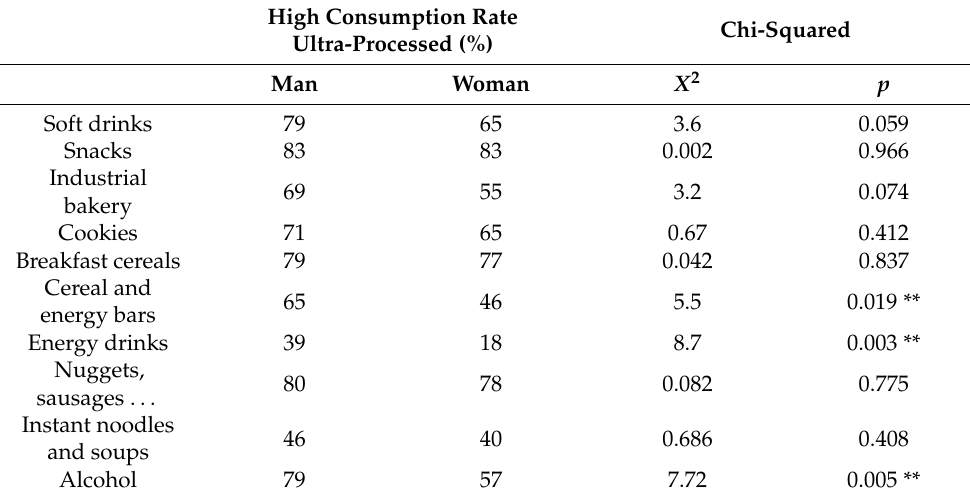
Table 7. Consumption of ultra-processed foods by gender.